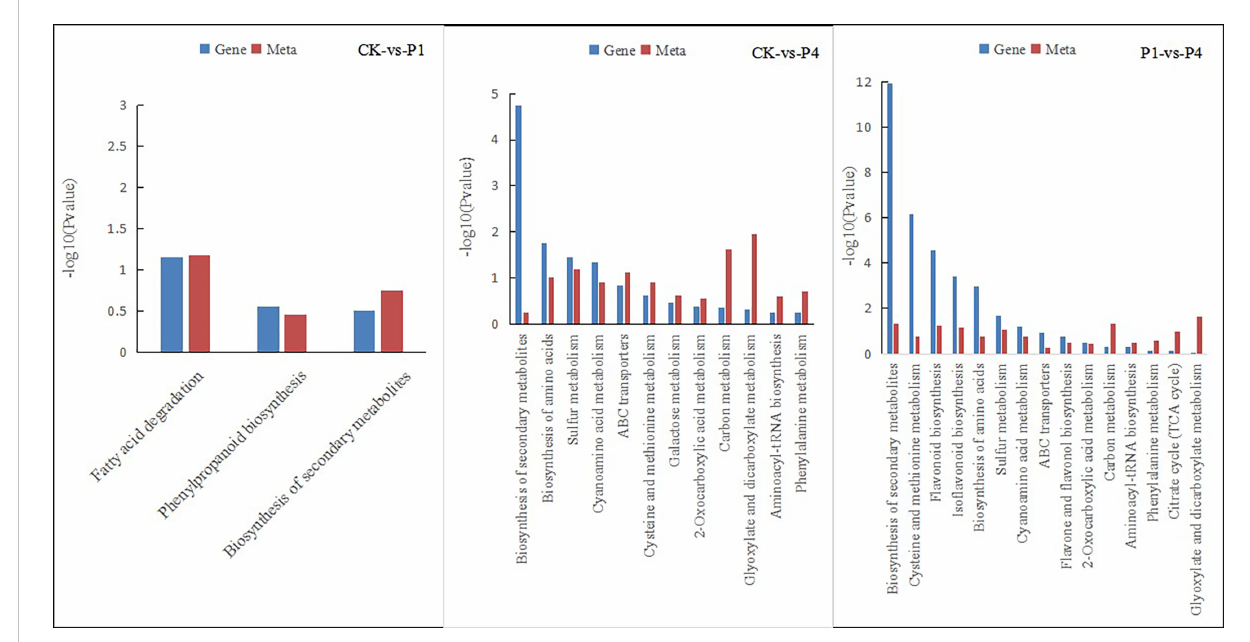
FIGURE 7 Pathways of the simultaneous annotation of differential metabolites and DEGs for different P treatments. DEGs, differentially expressed genes; P, phosphate.